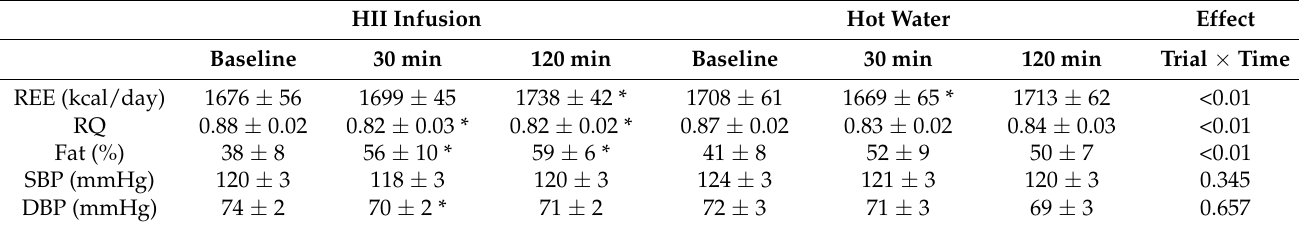
Table 3. The levels of REE, RQ, and hemodynamic parameters of 11 young men (mean ± SEM) at baseline, at 30 min and at 120 min post-intake.